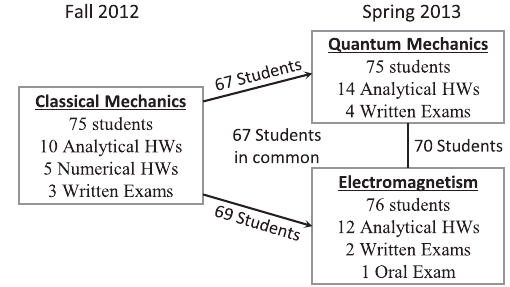
FIG. 1. Course information for classical mechanics, quantum mechanics, and electromagnetism. Lines connecting two courses indicate the number of students common to both courses. There were 67 students enrolled in all three